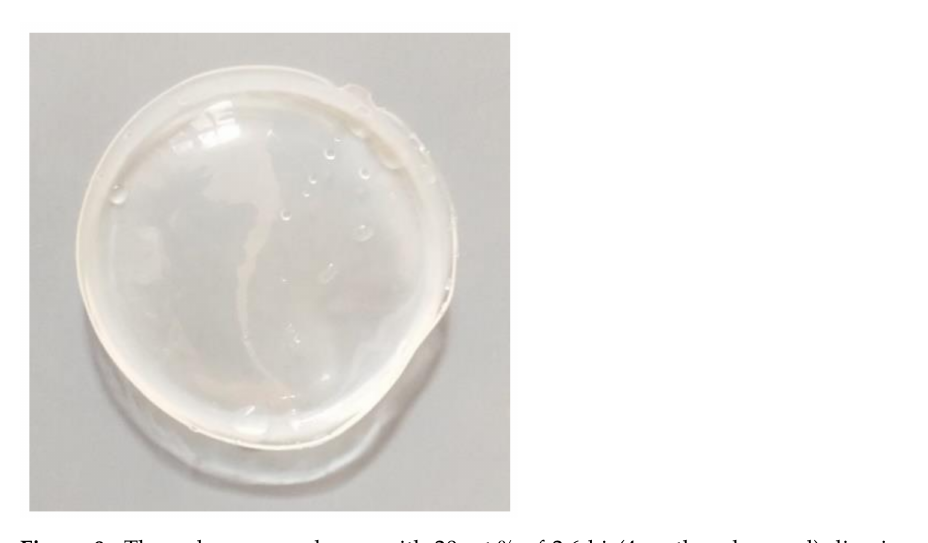
Figure 9. The polymer membrane with 20 wt.% of 2,6-bis(4-methoxybenzoyl)-diaminopyridine before the membrane extraction